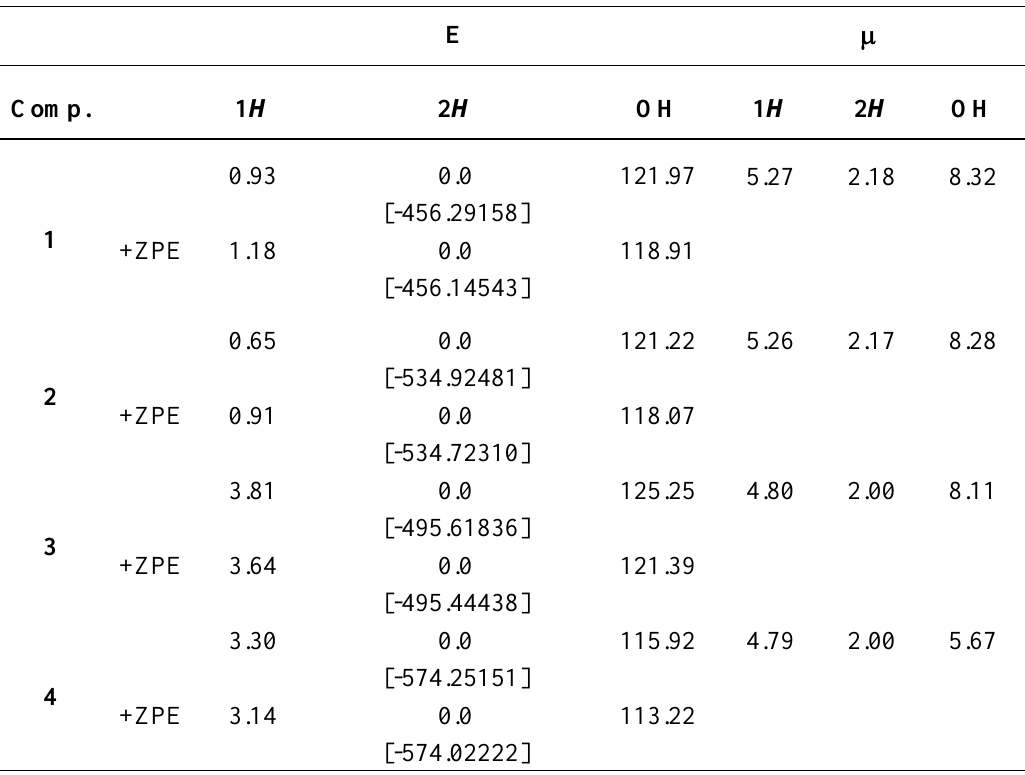
Table 4 . B3LYP/ 6-31G** Differences in energy (kJ mol –1 ), energies in brackets (hartree) and dipole moments